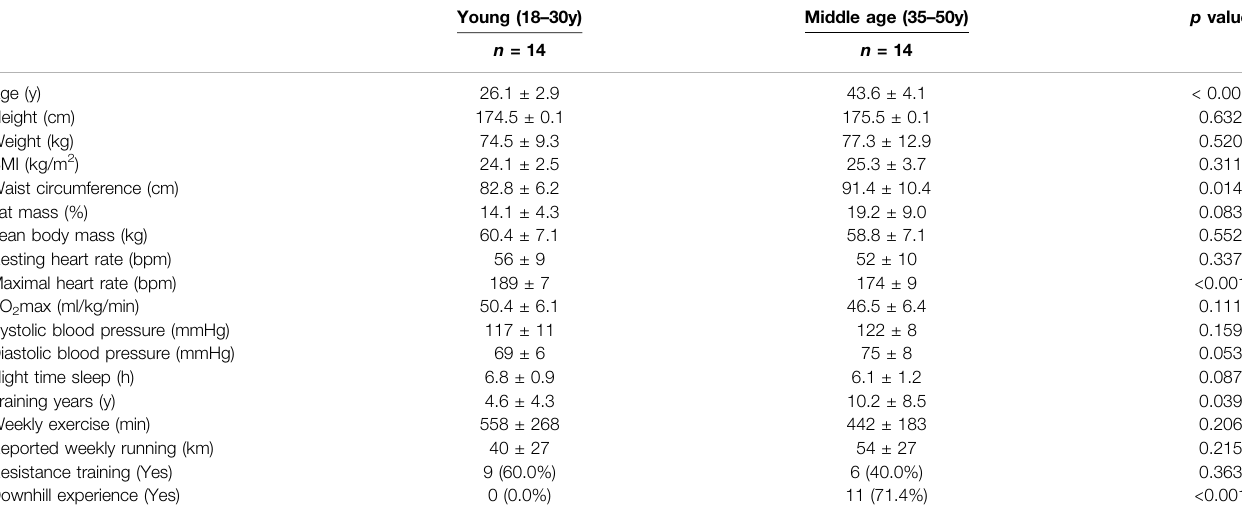
TABLE 1 | Baseline characteristics of the study population across age